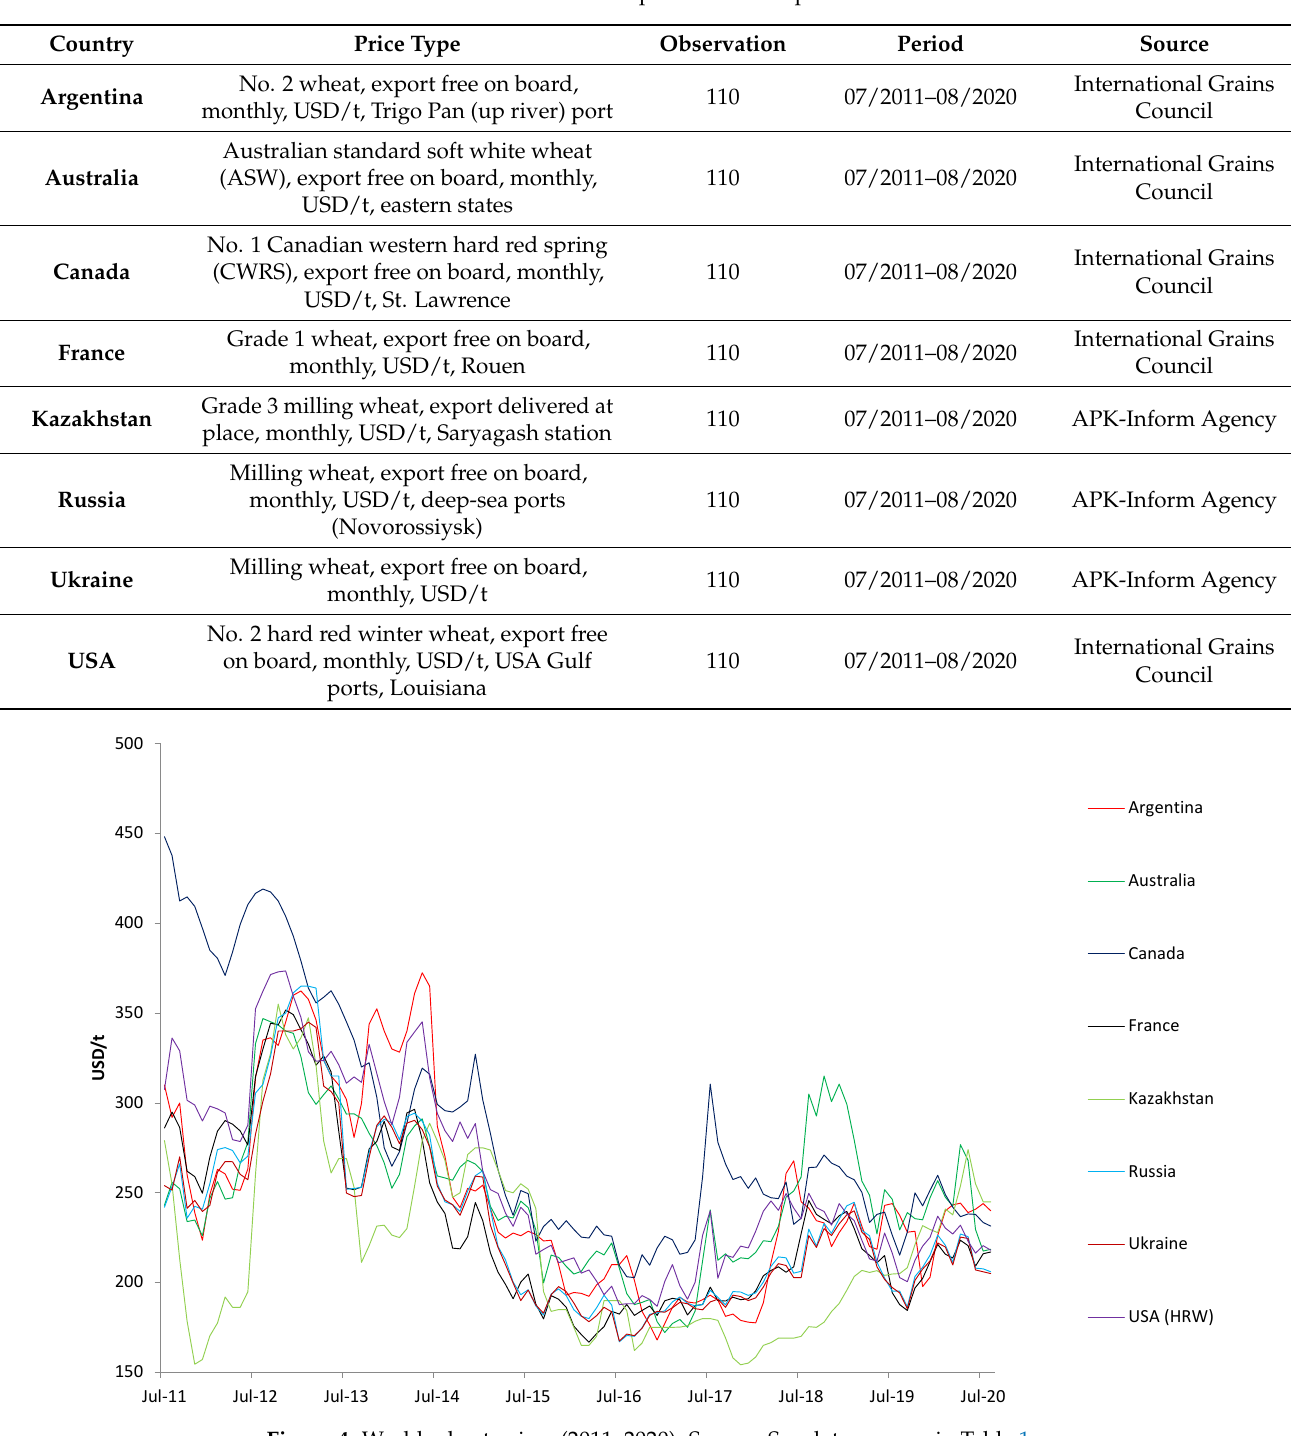
Table 1. Data description on wheat prices.